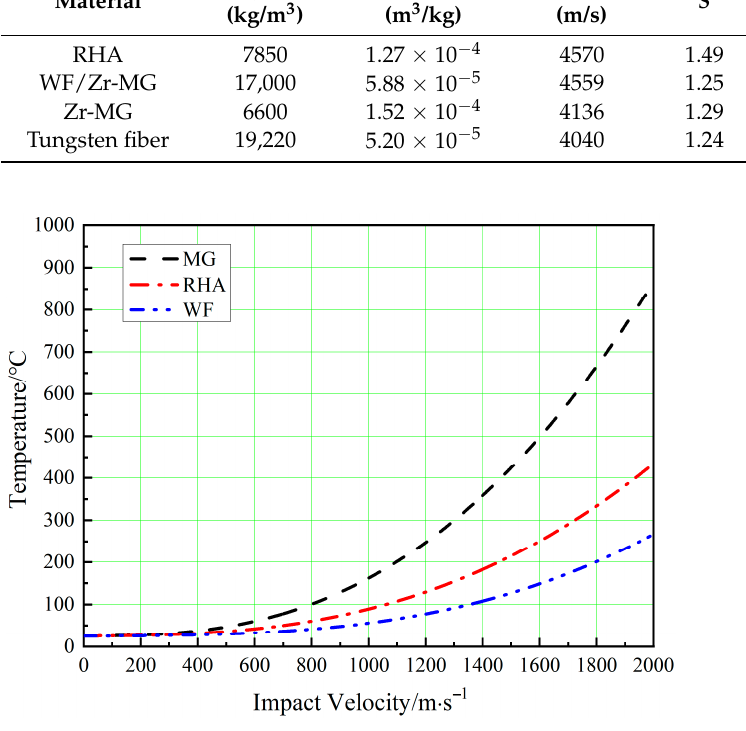
Figure 13. Relationship between temperature and impact velocity of Zr-MG, tungsten fibers, and RHA when WF/Zr-MG rods penetrate RHA.